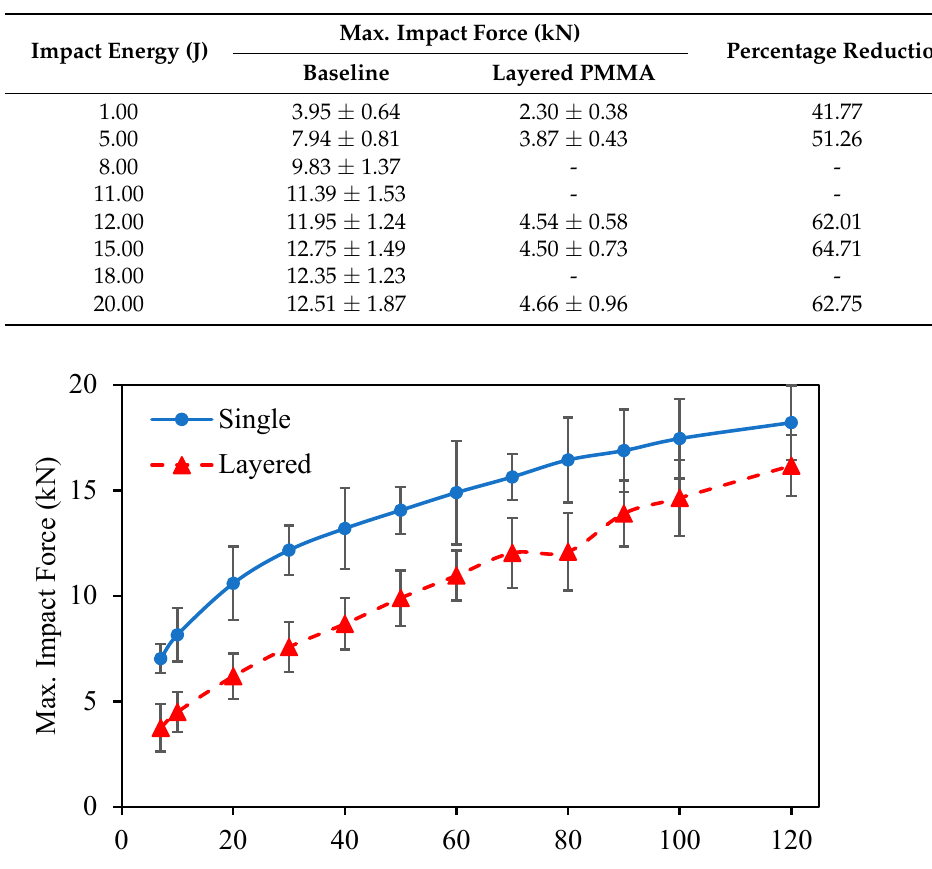
Figure 6. Variations of the maximum impact force for both baseline and layered Polycarbonate specimens as a function of impact energy.